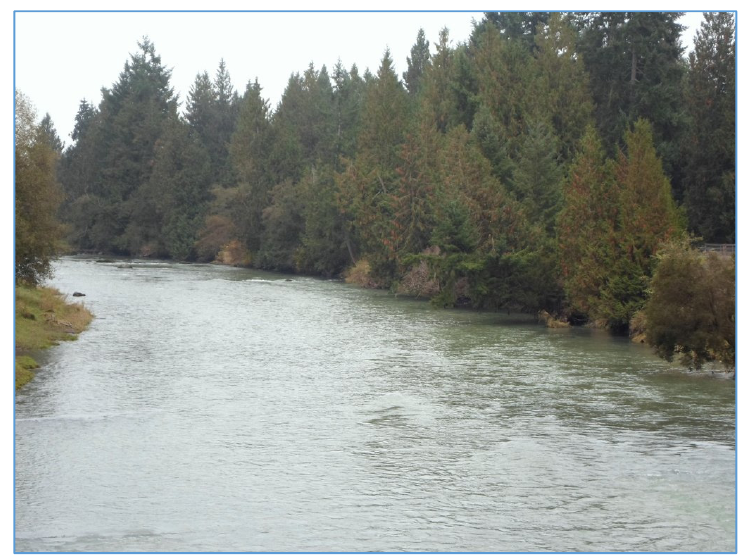
Figure 2. View of a typical LWM-depauperate river in the Pacific Northwest (Nisqually River, western Washington State).